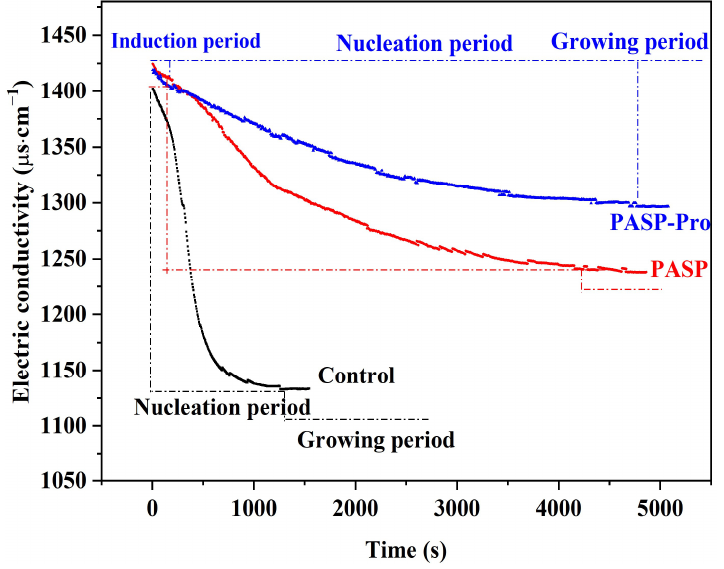
Figure 8. The conductivity changes with time in the nucleation process of CaCO 3 .